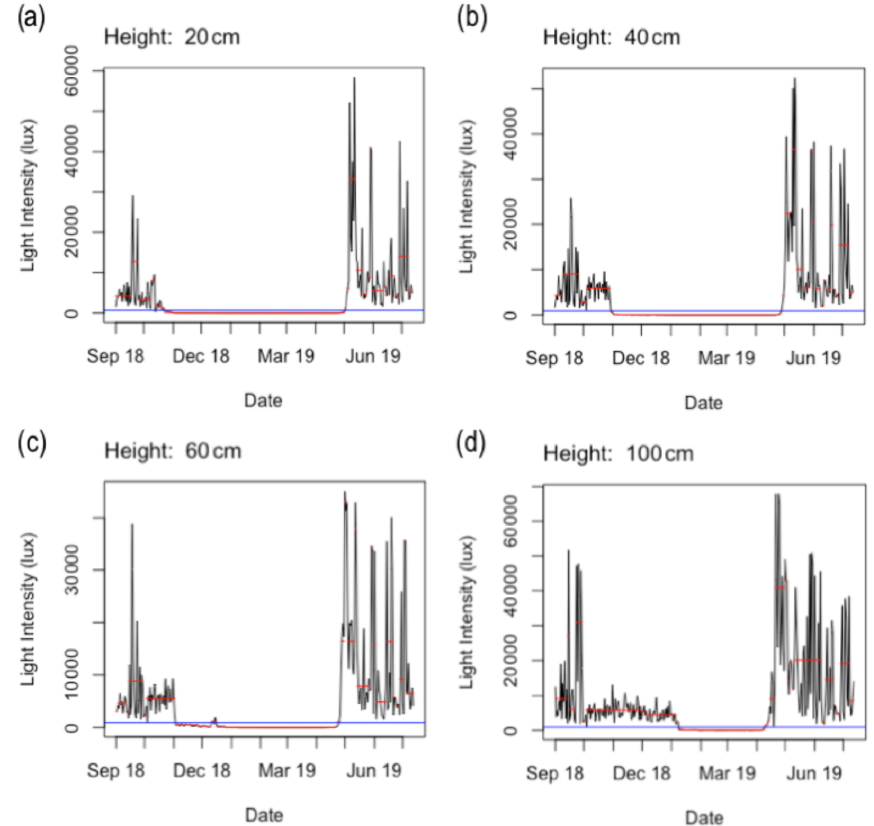
Figure 5. Change-point analysis applied to (a) 20, (b) 40, (c) 60 and (d) 100cm height loggers along Amet11. The red line shows change- point segment means, and the blue line shows the no-snow light intensity threshold for each logger. Snow cover occurs at a given logger when the change-point segment drops below the no-snow